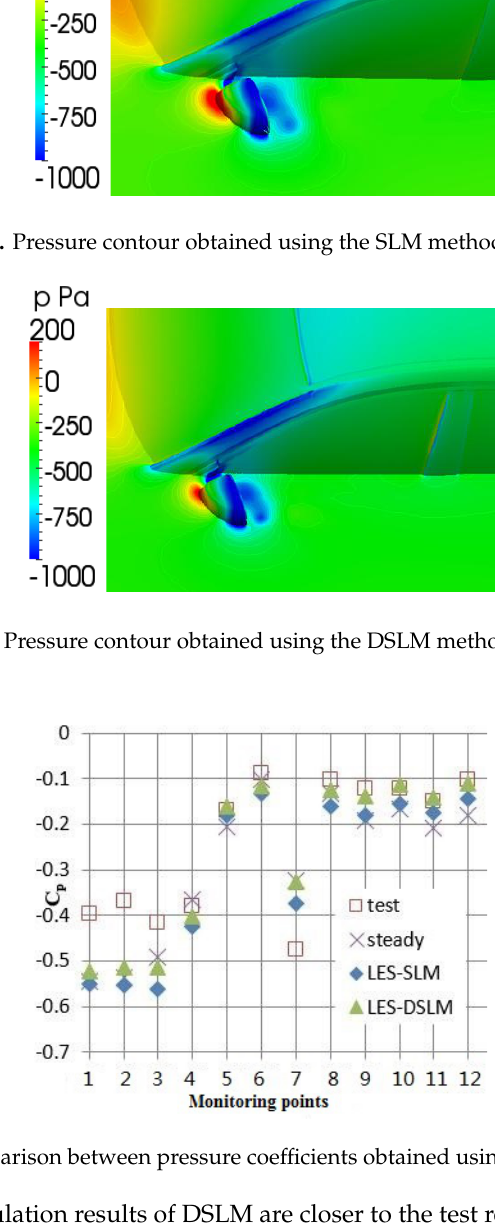
Figure 16. Comparison between pressure coefficients obtained using simulation and test.